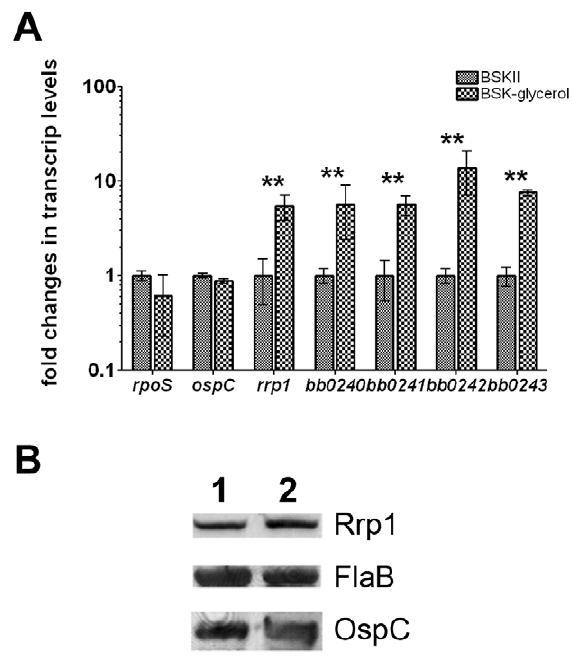
Figure 5. Glycerol induces expression of rrp1 and bb0240- bb0243 . Wild-type B. burgdorferi strain B31 5A4NP1 was grown at 35 u C in either standard BSKII or BSK-glycerol medium. Cells were harvested at late logarithmic phase. ( A ) qRT-PCR. RNAs were extracted and subjected to real-time RT-PCR analyses for rrp1 , bb0240 , bb0241 , bb0242 , bb0243 , rpoS , ospC , and flaB . Levels of expression of each gene were normalized with the level of flaB expression in each sample. Relative fold change of gene expression between the two growth conditions were reported (with levels of expression of each gene in standard BSKII media as values of 1). **, p , 0.01. ( B ) immunoblot against Rrp1, FlaB, or OspC. Lane 1, spirochetes cultivated in BSK-II medium. Lane 2, spirochetes cultivated in BSK-glycerol medium. Upon normalization against FlaB, Rrp1 level is 1.7 fold higher in BSK-glycerol medium than that in standard